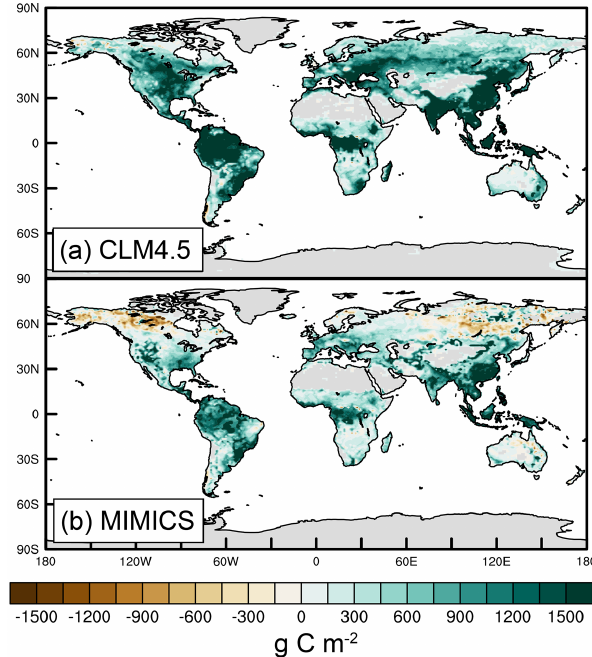
Figure 6. Spatial distribution of changes in soil C pools projected using (a) CLM4.5 and (b) MIMICS. Values (gCm − 2 ) were calcu- lated by subtracting the sum of all soil C pools (0–100cm) projected in 2100 under RCP 8.5 [CO 2 ] from those estimated in 2005. Pos- itive values show regions of net soil C accumulation over the 21st century with increasing litter inputs from elevated [CO 2